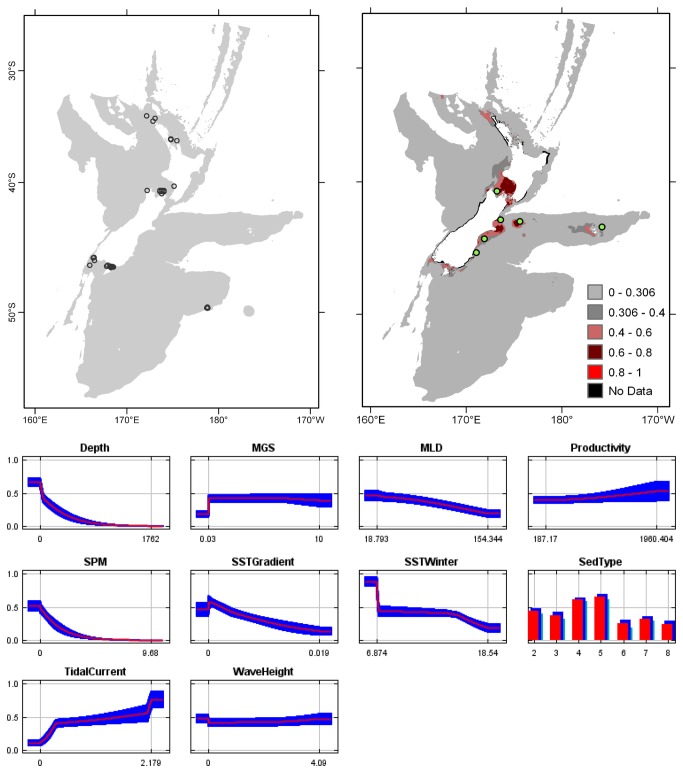

Hippomenella

vellicata
 known distribution (left), predicted suitable habitat (right), and fitted responses curves (marginal).For the predicted distribution, logistic probabilities less than the 10th percentile presence value indicated cells were unsuitable habitat. Probabilities of 0.4–0.6 indicated habitat suitability typical of the presence records, values of 0.6–0.8 and 0.8–1 indicated favourable and highly suitable habitat, respectively. Black cells had missing data in one or more environmental layer. Independent records are layed over the predictions. Marginal response curves show how the prediction changes for different values of each variable when all other variables were at their average sample value. Individual response curves are shown in Figure S3. For the categorical variable Sediment type: 1 = deep ocean clays; 2 = calcareous gravel; 3 = volcanic; 4 = calcareous mud; 5 = gravel; 6 = mud; 7 = sand; 8 = calcareous sand.